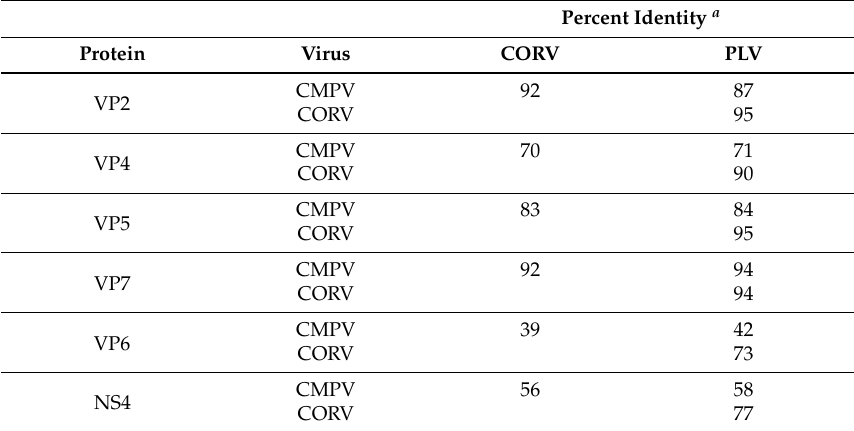
Table 3. Pairwise amino acid identities between CORV, PLV and CMPV.